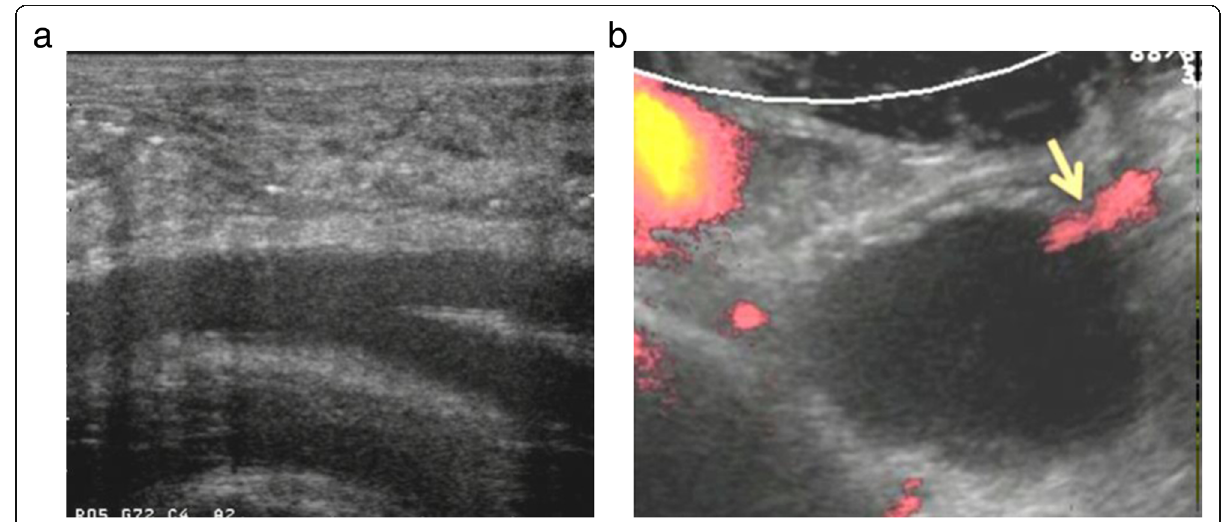
Fig. 5 a Ultrasonographic image of an edematous infiltration of the left inguinal soft tissues. b Low repleted bladder with an abnormal Doppler signal going from the bladder to the cutaneous tissue